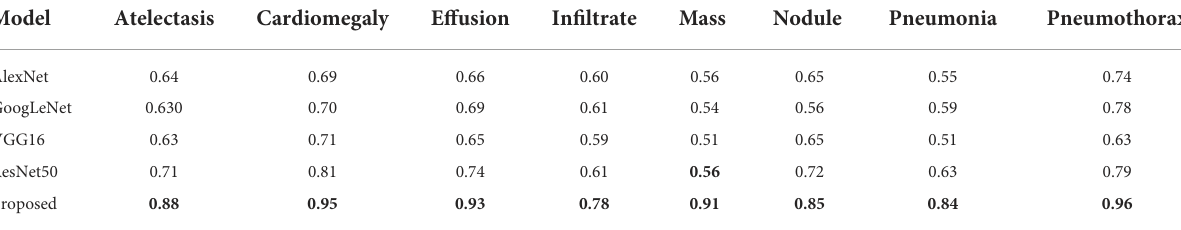
TABLE 3 Comparison with base models in terms of the AUC metric.